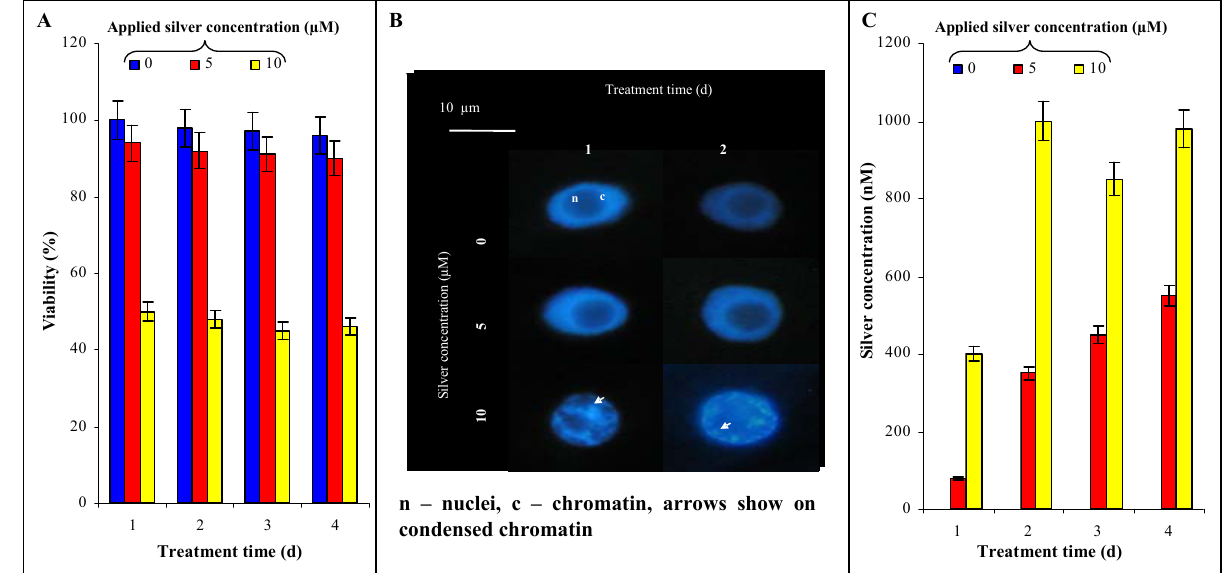
Figure 6. Tobacco cells. (A) Changes in viability of tobacco BY-2 cells treated with 0, 5 and 10 µM silver(I) ions for 4 days. (B) The influence of silver(I) ions on nuclei and chromatin condensation. (C) The content of silver(I) ions in the treated tobacco